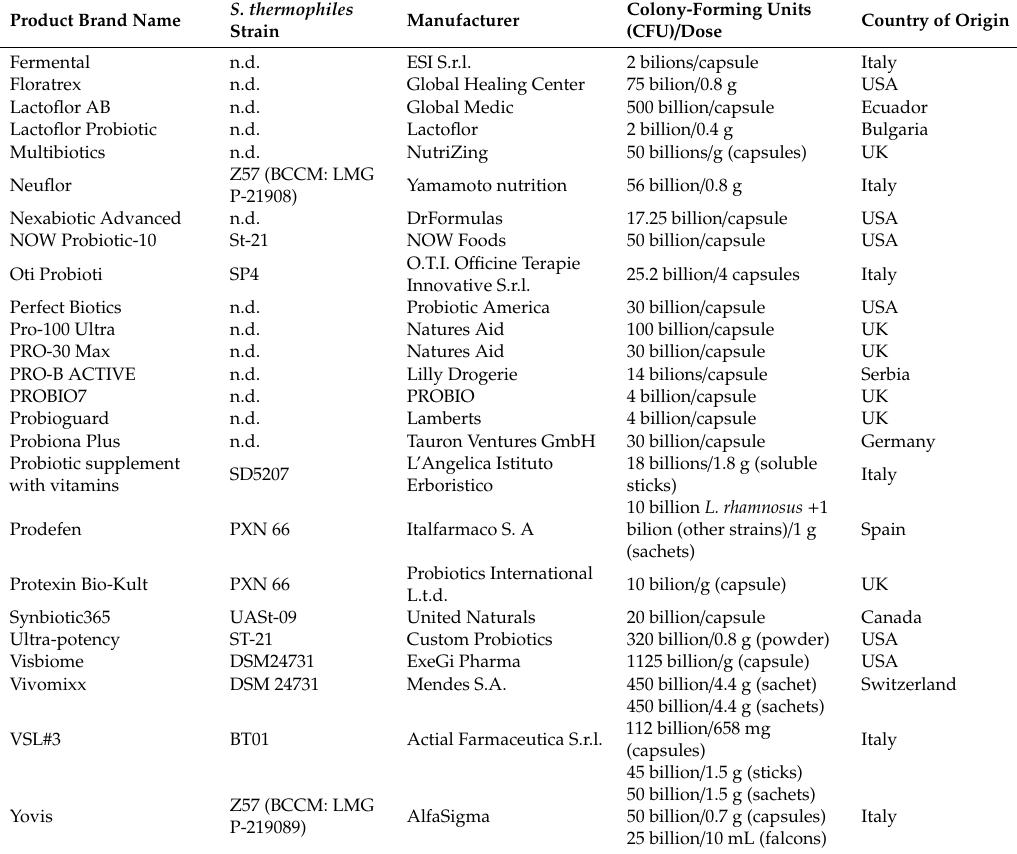
Table 1. List of chosen probiotic products available on the international market containing S. thermophilus